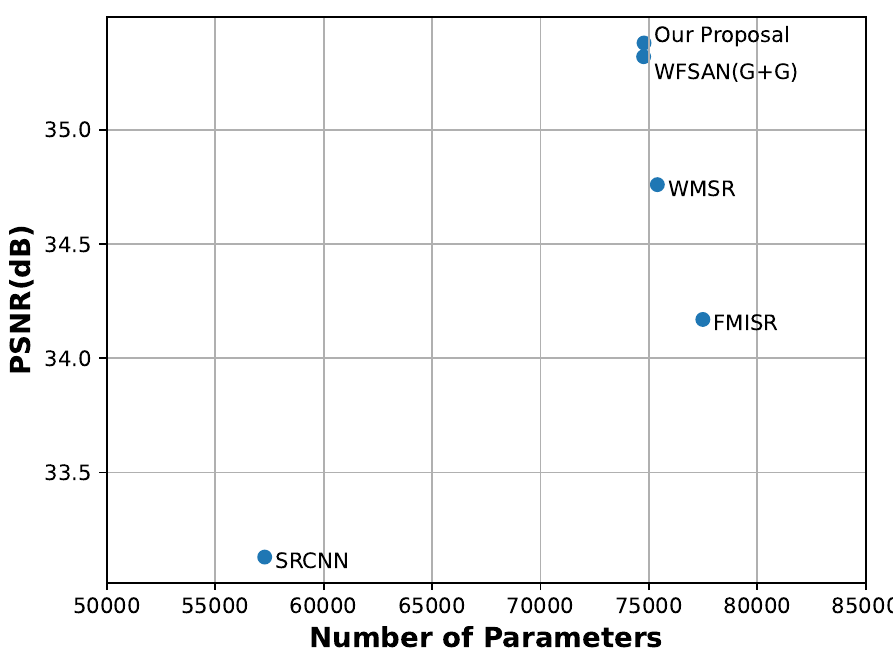
Figure 12. PSNR(dB) versus number of parameters for different methods on MontgomerySet abnor- mal data set.